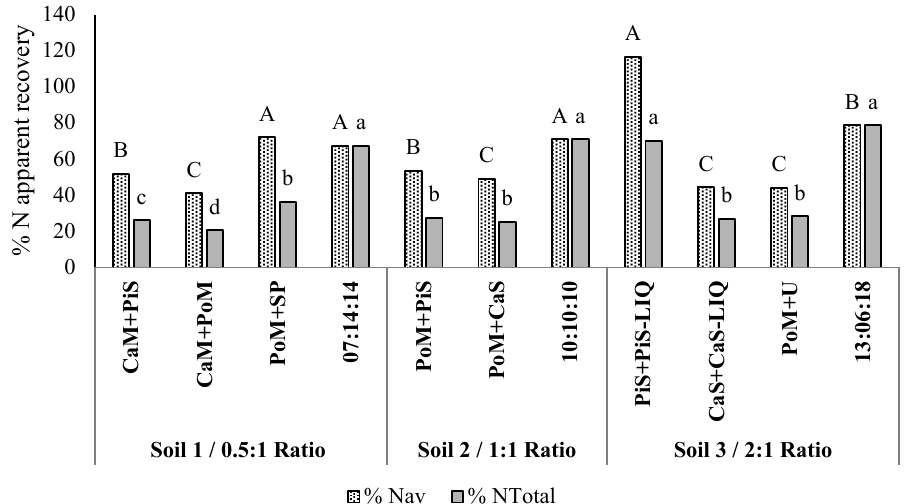
Figure 2. Apparent nitrogen recovery for oat fertilized with different MBFs and MFs, expressed as a percentage of available N (Nav) and total N (NTotal) applied. Results for each ratio in each column followed by different letters differ significantly for p < 0.05 (Tukey test), with capital letters referring to Nav and small letters referring to NTotal. PiS: pig slurry; PiS-LIQ: liquid fraction from